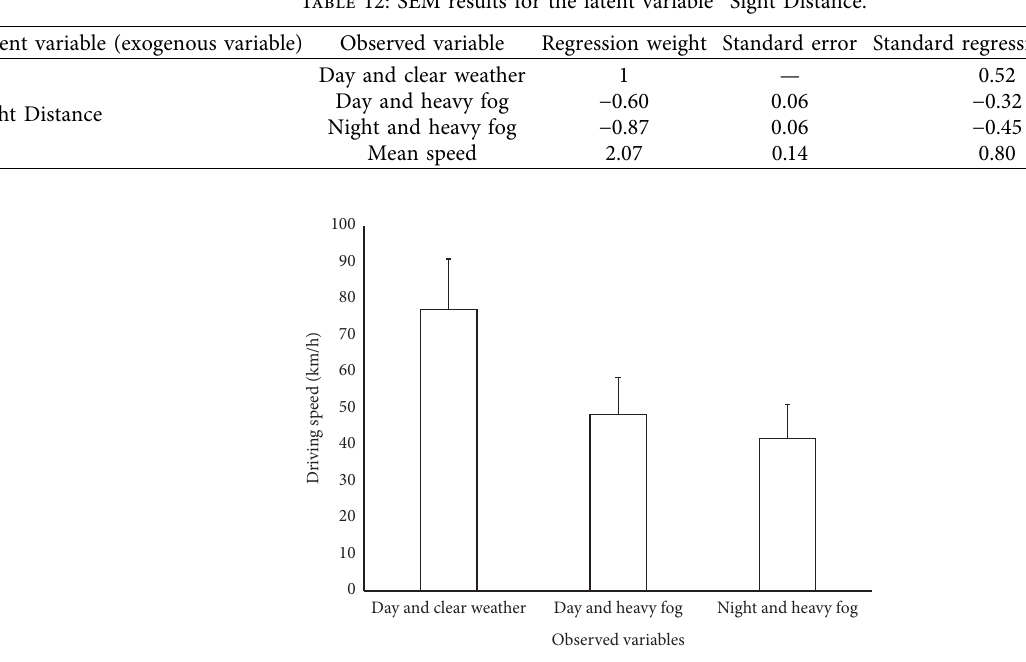
Figure 9: Speed statistics for variables involved in the latent variable “Sight